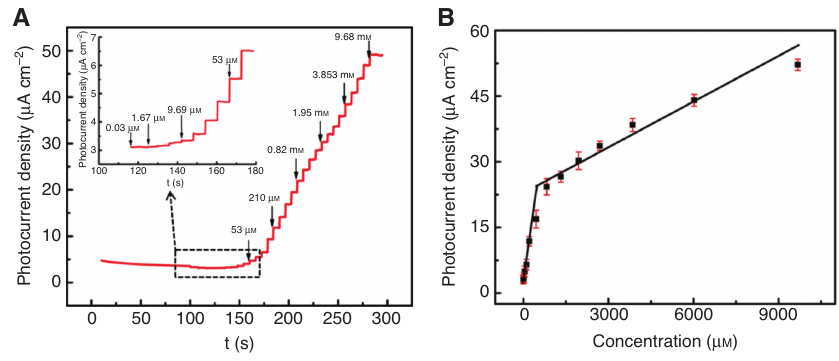
Figure 6: The concentration of NGQDs dispersion is 0.5 mg/ml. (A) Transient photocurrent density vs. time plotted for the NGQDs electrode in BR buffer solution (pH 4.0) containing different concentrations of DA from 0.03 to 450 and from 50 to 9680 μ m under UV light illumination. Inset: Amplification of the i - t curve at the low concentration region. (B) Plots of photocurrent density vs. the concentration of